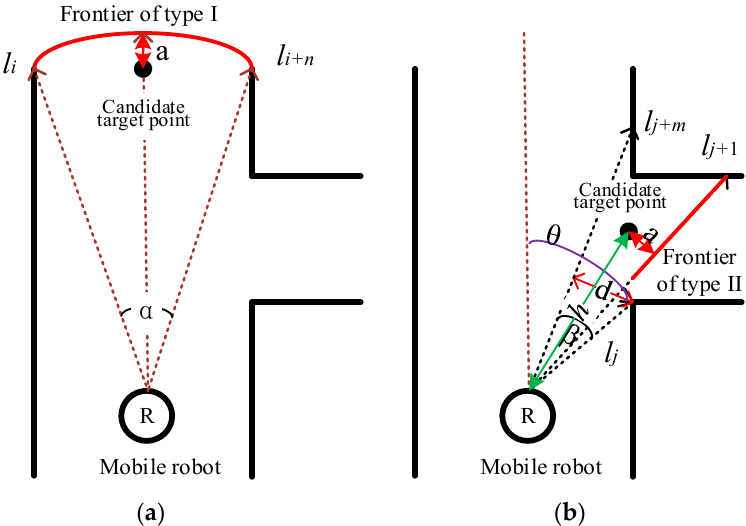
Figure 2. Two types of frontiers and the generation of candidate target points: ( a ) Frontier of type I; ( b ) Frontier of type II.